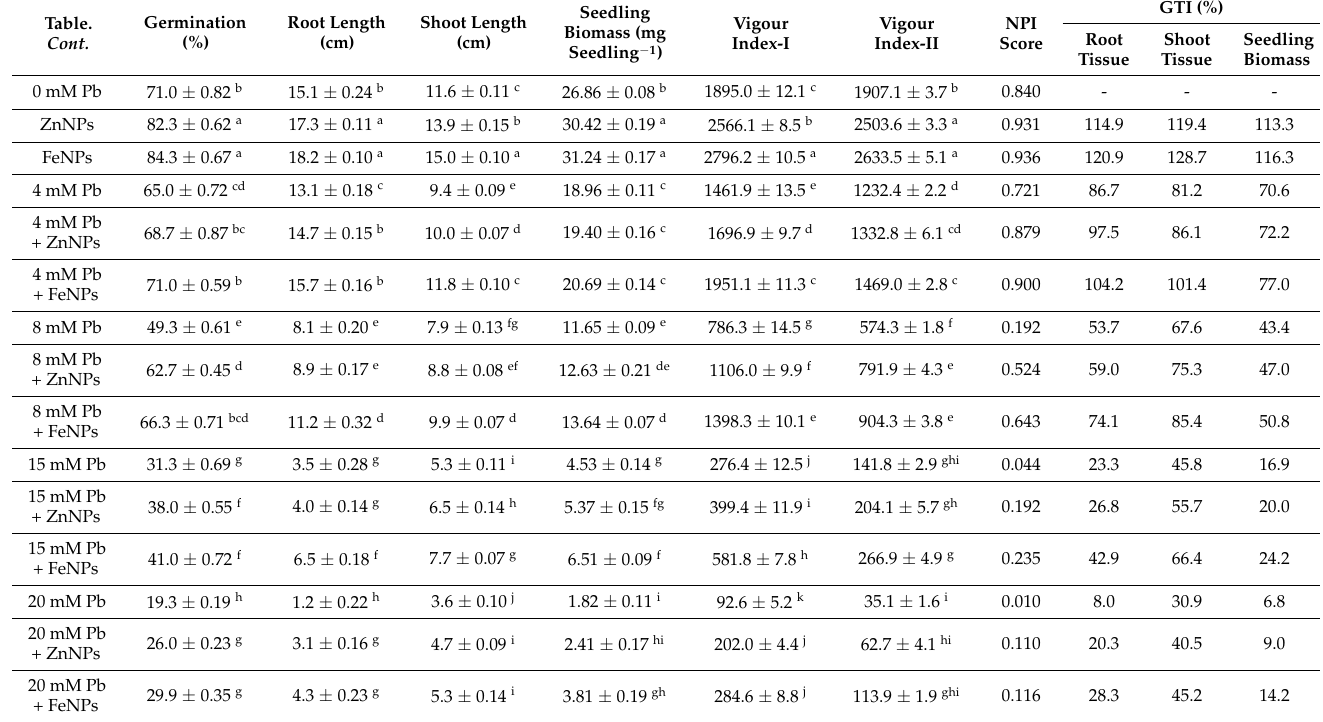
Values in the table are the mean of four replications ± standard error (SE). Different letters in each row are statistically significant at p < 0.05 level. Germination values are expressed in percentage and transformed to the respective angular (arc sin) values before subjecting them to statistical